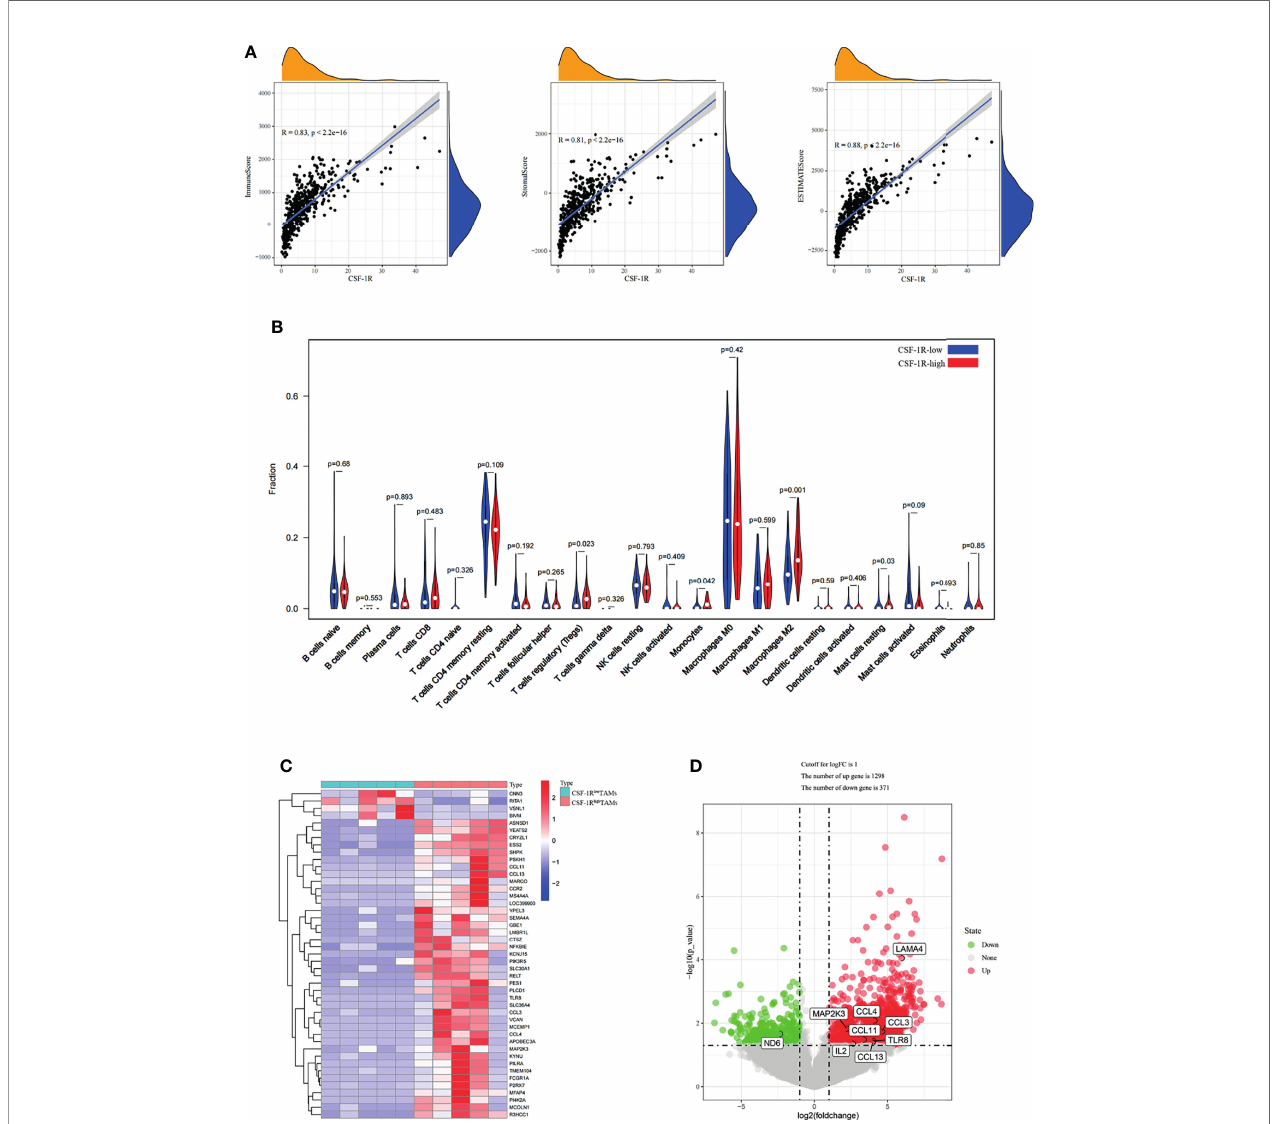
FIGURE 5 | CSF-1R high TAMs affect the immune landscape of colon adenocarcinoma. (A) Associations between CSF-1R expression and tumor microenvironment in COAD. (B) CIBERSORT analysis of the fractions of in fi ltrated immune cells in the COAD. (C) Heatmap of the partially differentially expressed genes between CSF- 1R low TAMs and CSF-1R high TAMs. (D) Volcano map of differentially expressed gene between CSF-1R low TAMs and CSF-1R high TAMs. In the Volcano, p < 0.05 was set as the cut-off criterion of signi fi cant